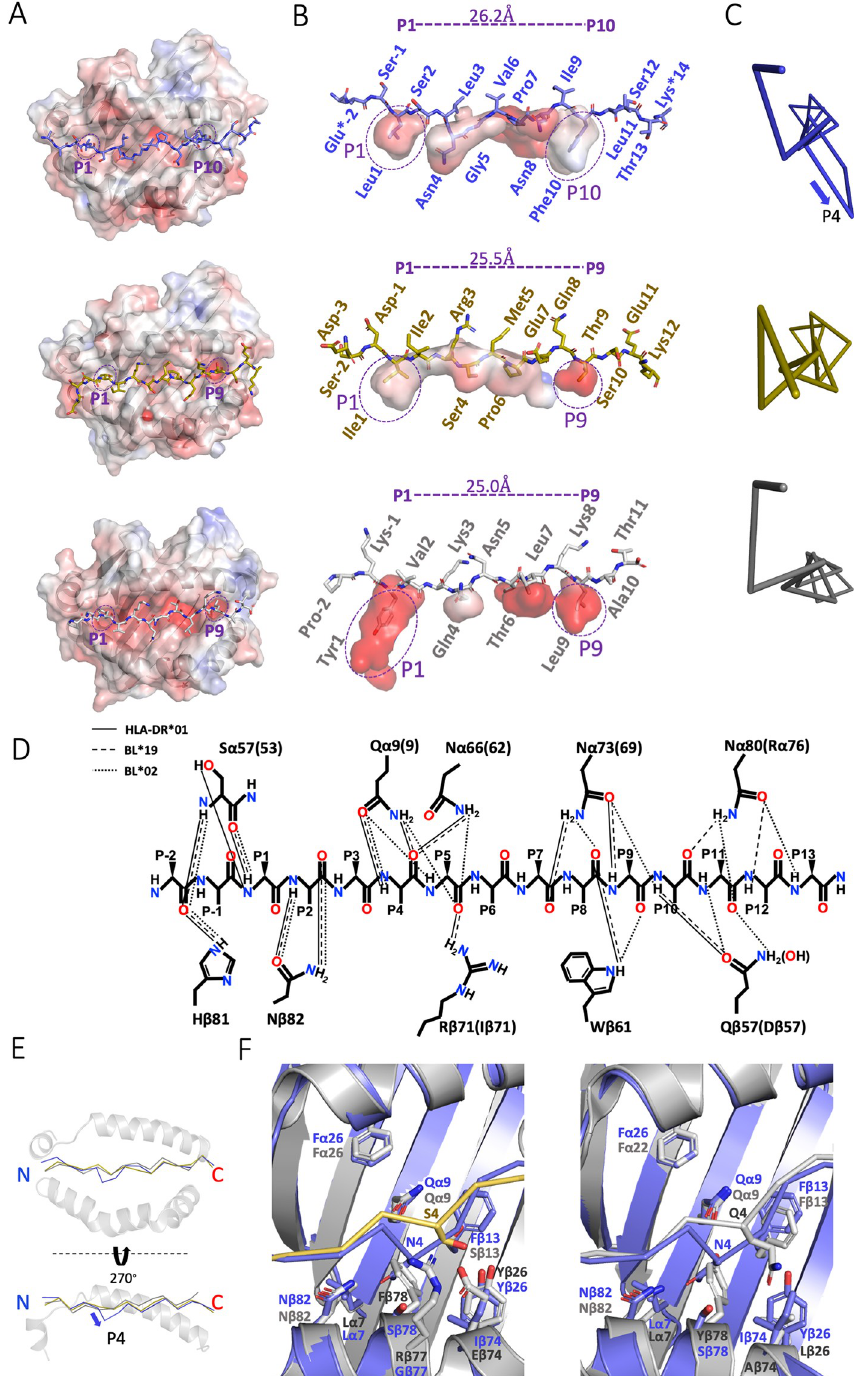
Fig 4. Although similar in overall structure to other class II molecules, BL2 � 02 binds peptides with a decamer motif due to Ser β 78. (A–C) Top panels, BL2 � 02 (PDB accession 6T3Y); middle panels, BL2 � 19 (6KVM); bottom panels, DR1 � 01 (1DLH). (A) Top view of solvent-accessible surface of class II molecules calculated by APBS electrostatics (positive charge, blue; negative charge, red) with P1, P9, and P10 pockets indicated and with peptides in sticks. (B) Side view of peptide in sticks with amino acids indicated and with pockets as surfaces with P1, P9, and P10 pockets indicated, and with length between C α of P1 and P9 or P10 shown (blue asterisks indicate that the side chains are not resolved). (C) Edge-on view of peptide C α backbone, with arrow indicating departure of P4 in BL2 � 02 from the polyproline II helix. (D) Schematic of H-bonds interacting with peptide main chain atoms (cut-off of 3.2 Å )